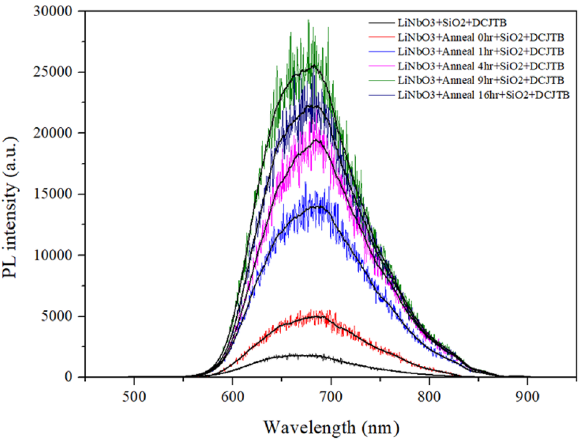
Figure 6. Photoluminescence (PL) of the flat LiNbO 3 substrate and the fabricated PPE LiNbO 3 substrates under different annealing times of 0, 1, 4, 9, and 16 h.